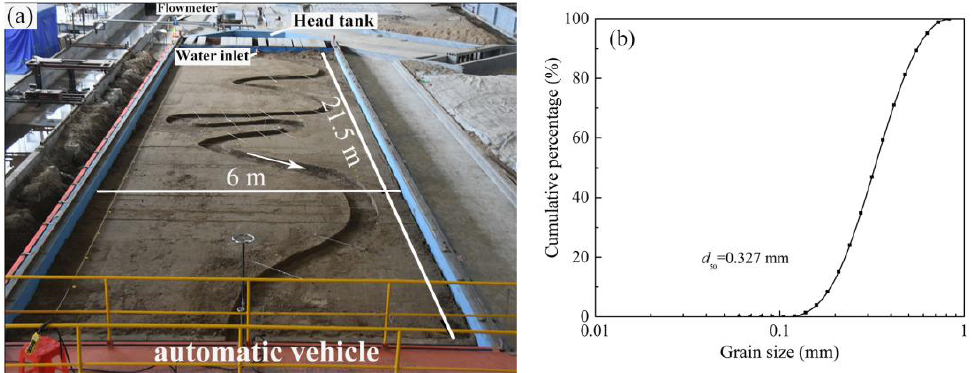
Figure 1. ( a ) Experimental system and ( b ) particle size distribution